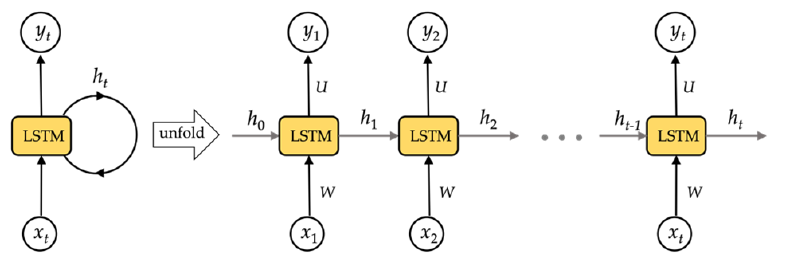
Figure 4. The structure of LSTM